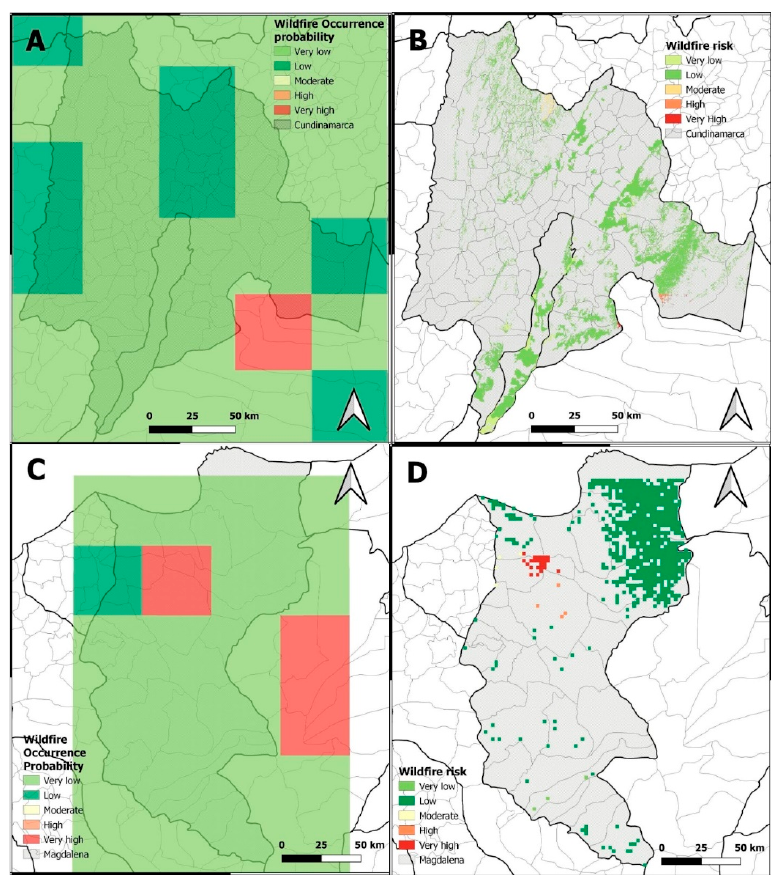
Figure 10. Wildfire Occurrence Probability of Cundinamarca ( A ) and Magdalena ( C ); Wildfire Risk Map in Cundinamarca ( B ) and Magdalena ( D ) on 27 December 2020. Colors represented as very high (red), high (orange), moderate (yellow), low (green), very low (light green).